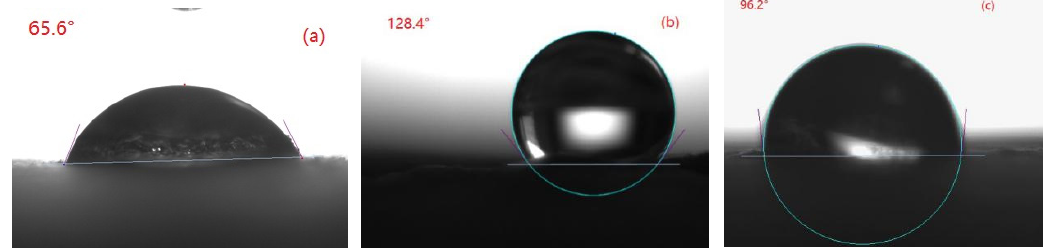
Figure 3. Contact angle of the concrete surface: ( a ) untreated; ( b ) treated by silane emulsion; ( c ) treated by SiO 2 .